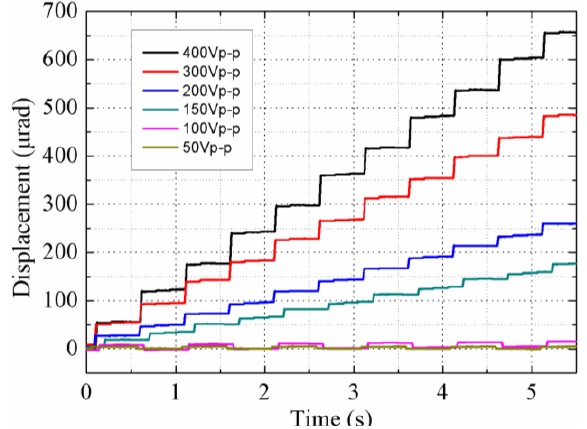
Figure 8. Plot of the output displacement versus the time.